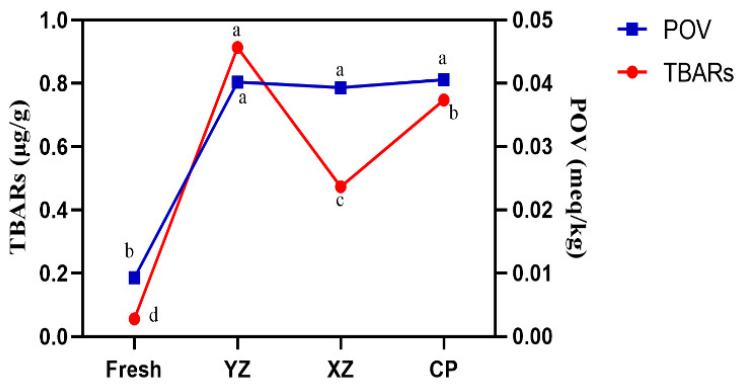
Figure 1. Changes of POV and TBARS content in different stages. Fresh: raw sample; YZ: cured sample; XZ: smoking sample; CP: finished sample; POV: peroxide value; TBARS: thiobarbituric acid reactive substance.